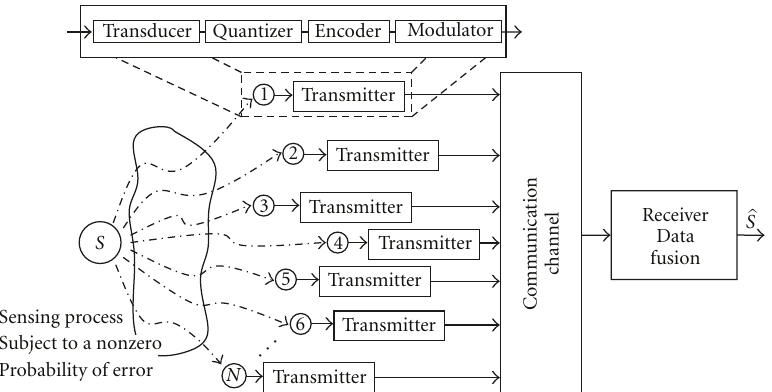
Figure 1: Generic data fusion scenario where N nodes sense a certain physical parameter S , and transmit the sensed information to a joint